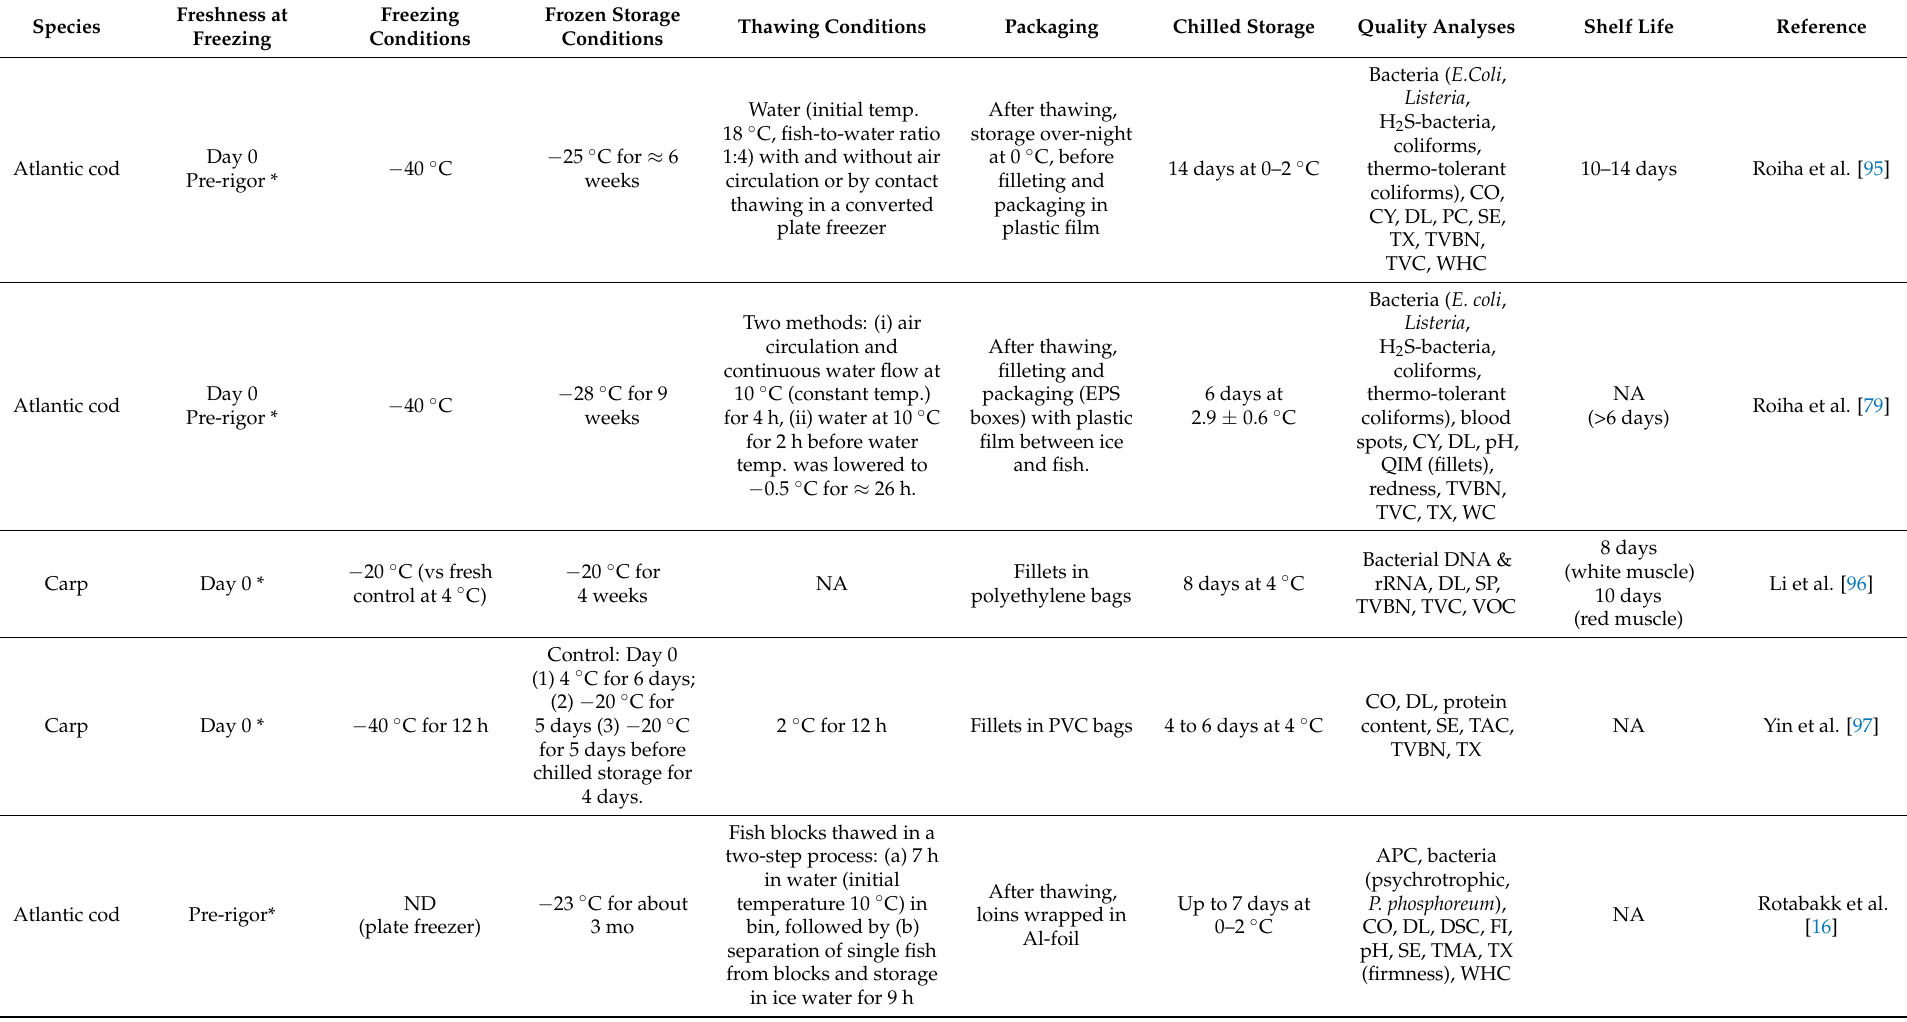
Table 1. Freeze-chilling of fish: Overview of fish species, initial freshness (day 0 is defined as day of capture and death), freezing temperatures, frozen and chilled storage temperatures and durations for each step in the value chain, type of packaging, as well as parameters used for assessment of quality for each